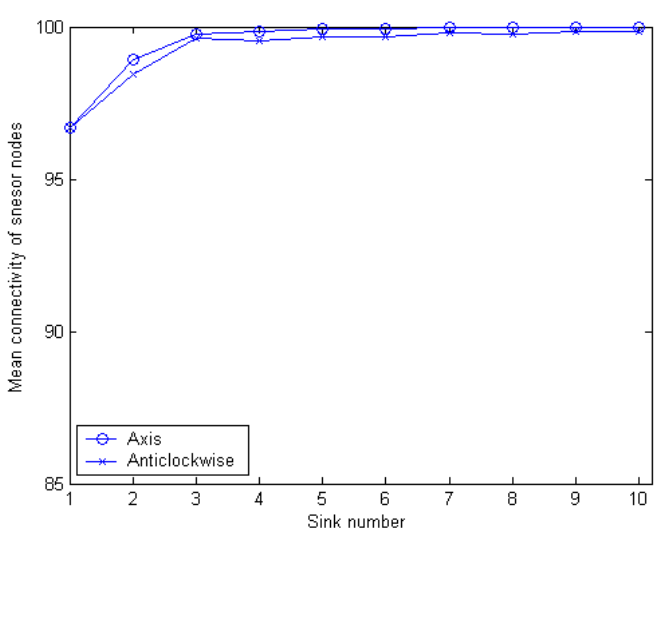
Figure 15. Mean connectivity of MSCWSNs-PC at variety sink number with considering BCP (mean of 1,000